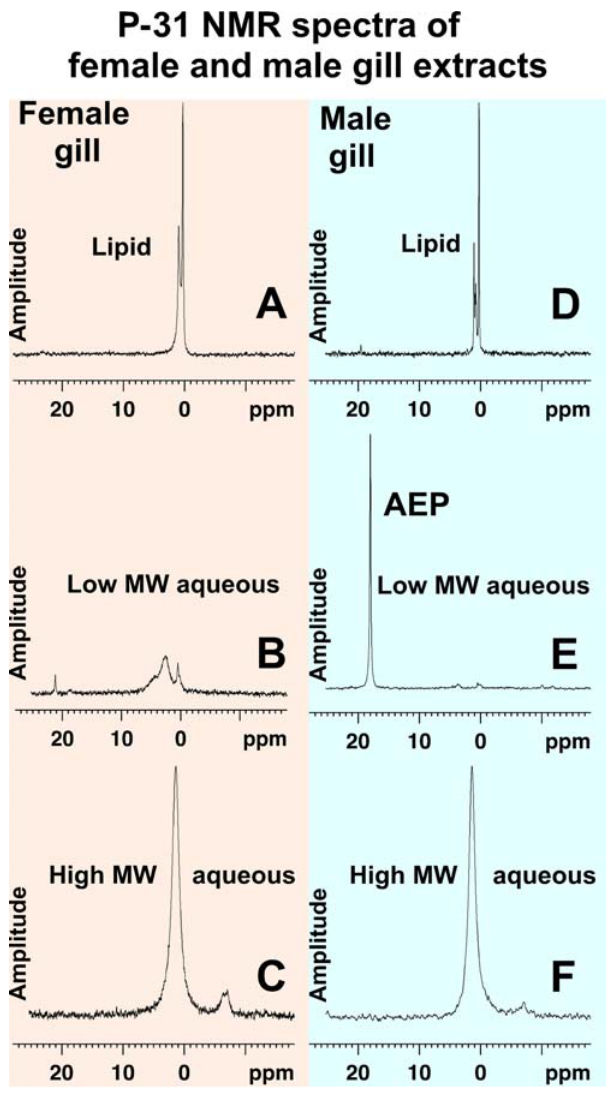
Figure 5. P-31 NMR spectra of female and male gill extracts. Six P-31 NMR spectra showing the three fractions A, B and C, obtained from the 1% AEP female gill and D, E and F from the male gill of Figure 1. Panels (A) and (D) present the lipid extract. Panels (B) and (E) present the low molecular weight aqueous extract. Panels (C) and (F) show small phosphorus compounds released by the acid hydrolysis of the high molecular weight aqueous fraction. The lipid extract (chloroform:- methanol 2:1) from the female (A) and male (D) show the expected phospholipids. The low MW aqueous extraction from the female (B) has the expected orthophosphate and its esters (0 to 4 ppm) and also containing a small amount of AEP. This spectrum documents that there was nothing within intact female gill masking the appearance of AEP from P-31 NMR. The addition of sodium ethylenediaminetetraacetate, a polyvalent metallic cation chelating agent, did not alter the relative